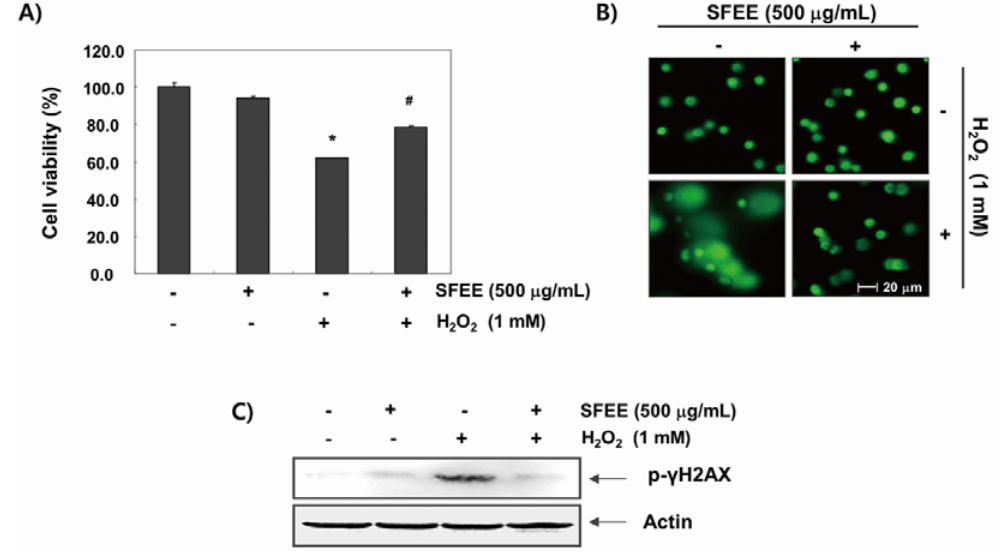
Figure 2. Effects of Schisandrae Fructus ethanol extract on H 2 O 2 -induced growth inhibition and DNA damage in C2C12 cells. ( A ) C2C12 cells were pretreated with 500 μg/mL SFEE for 1 h, incubated with and without 1 mM H 2 O 2 for 6 h, and cell viability was measured. The results are mean ± standard deviation (SD) values obtained from three independent experiments ( * p < 0.05 compared with control group; # p < 0.05 compared with H 2 O 2 -treated group); ( B ) The comet assay using cells grown under the same conditions as in ( A ) was performed to detect cellular DNA damage, and representative photographs of the comets were taken using a fluorescence microscope (200 × original magnification); ( C ) The cells were lysed, and equal amounts of the cell lysates were separated on sodium dodecyl sulphate (SDS)-polyacrylamide gels and transferred to nitrocellulose membranes. The membranes were probed with specific antibodies against phospho-histone γH2A.X and actin, as an internal control, and the proteins were visualized using an enhanced chemiluminescent detection system. A representative blot from three independent experiments is shown. SFEE, Schisandrae Fructus ethanol